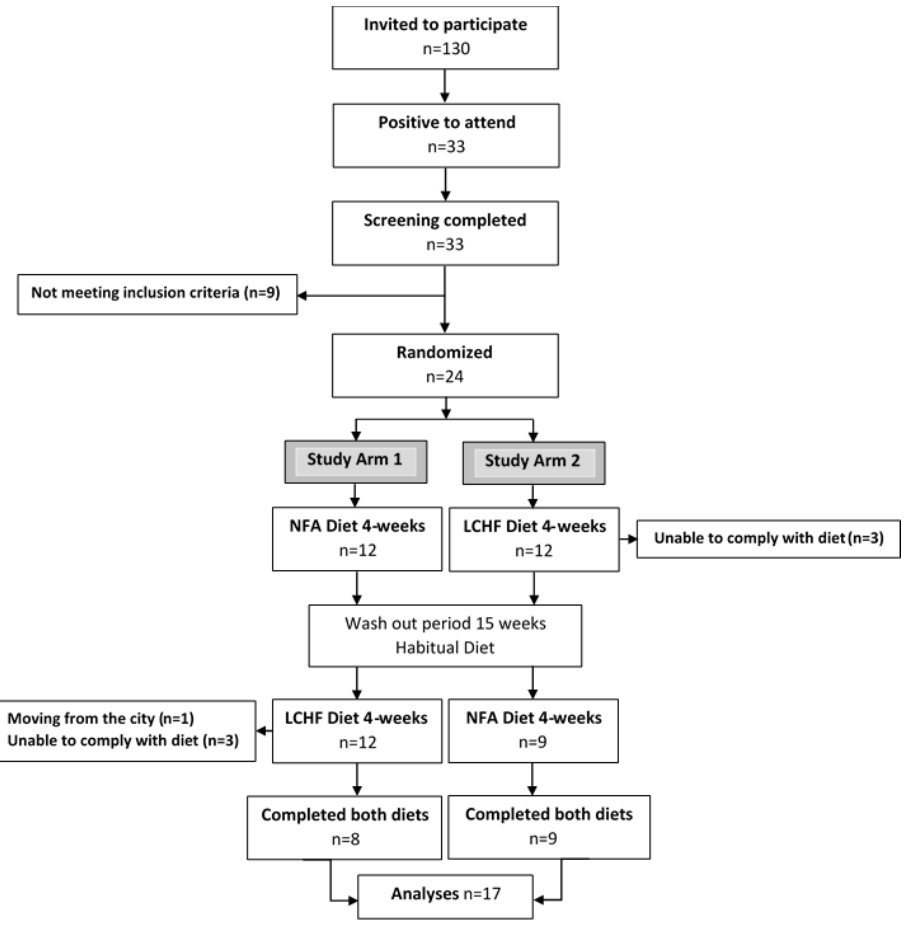
Figure 1. Consort flow chart. Adapted from [27]. NFA Diet, a National Food Agency recommended